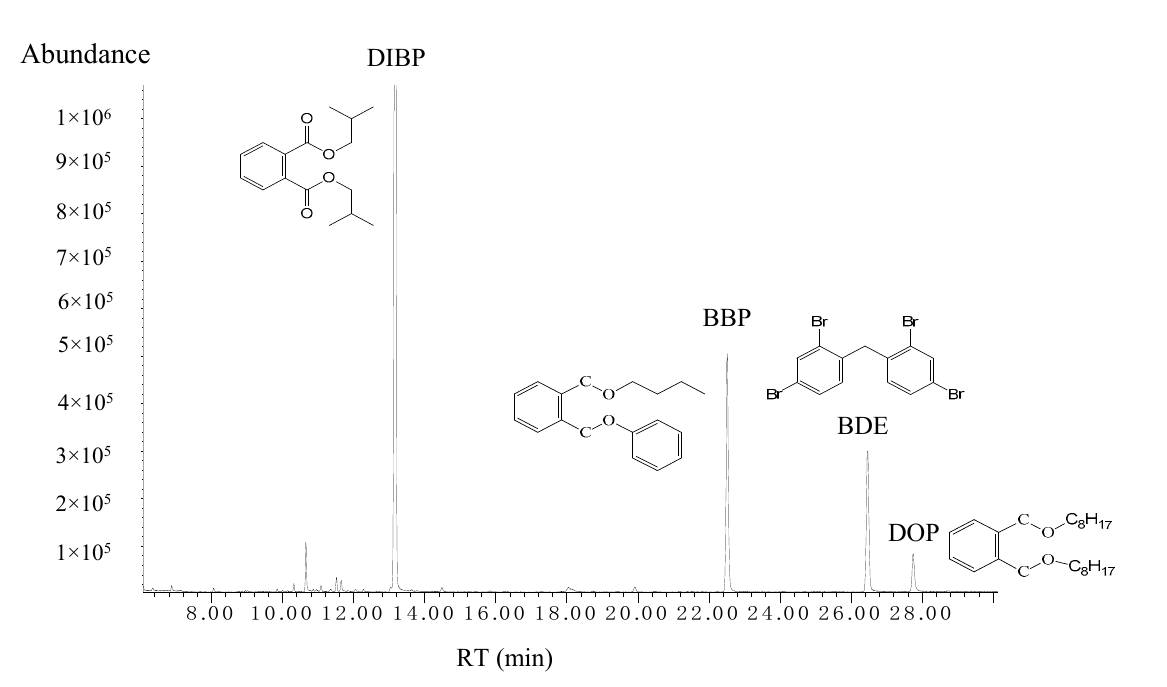
Figure 2. HS-SPME/GC-MS chromatograms of phthalates at 60 µg/L using PDMS/DVB fiber at 80 °C for 30 min. Table 1 summarizes the phthalates involved in the current study, RT, linear range, R 2 , LOD, and LOQ, whereas Table 2 reports the recovery and precision data. Table 1. Figures of merit of the phthalates HS-SPME/GC-qMS methodology. RT (min) PAEs Linear Range (µg/L) Equation R 2